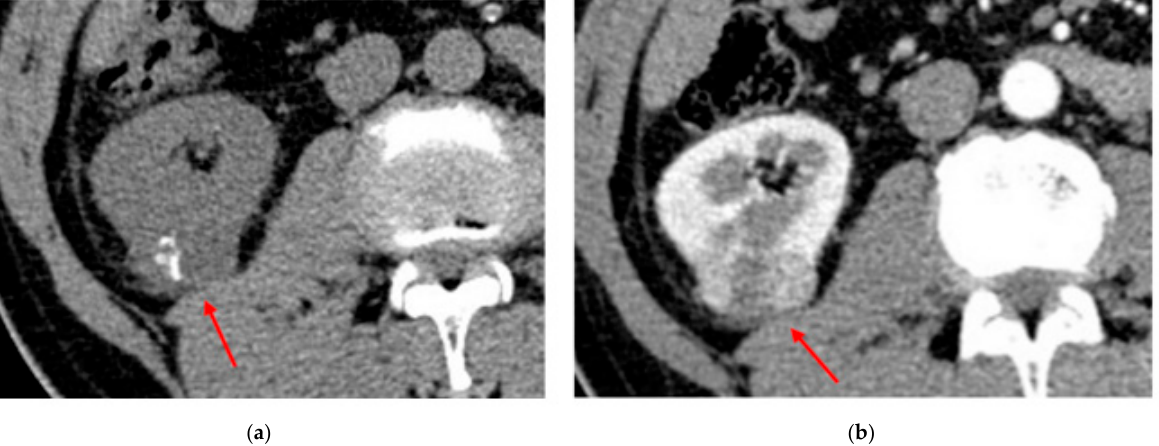
Figure 7. Another example of histologically confirmed chRCC showing ( a ) multiple macroscopic calcifications in a noncontrast CT and( b ) the typical enhancement